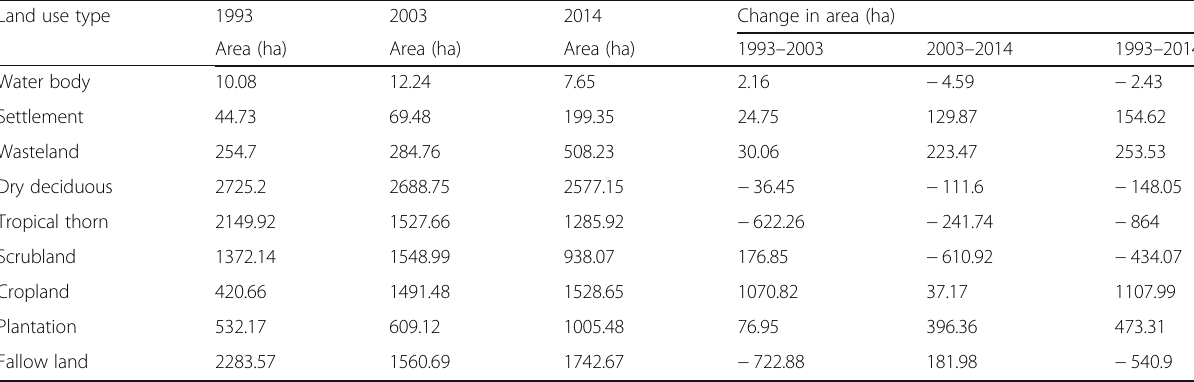
Table 4 Land use/land use change patterns (1993 –